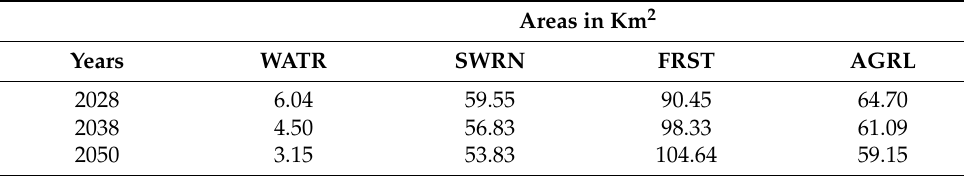
Table 5. Land use class areas from 2028 to 2050.